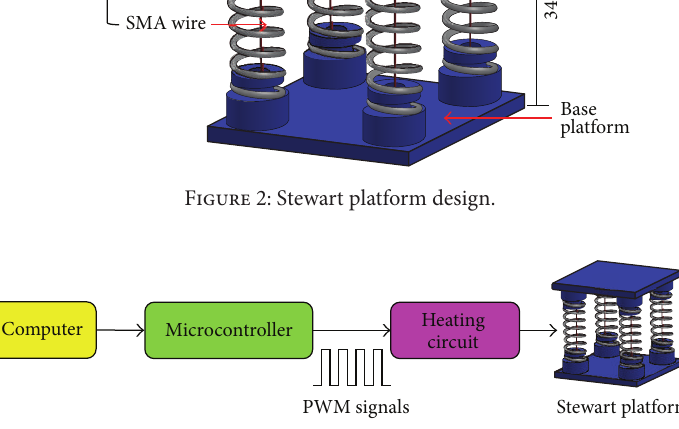
Figure 3: Working principle of the Stewart platform.